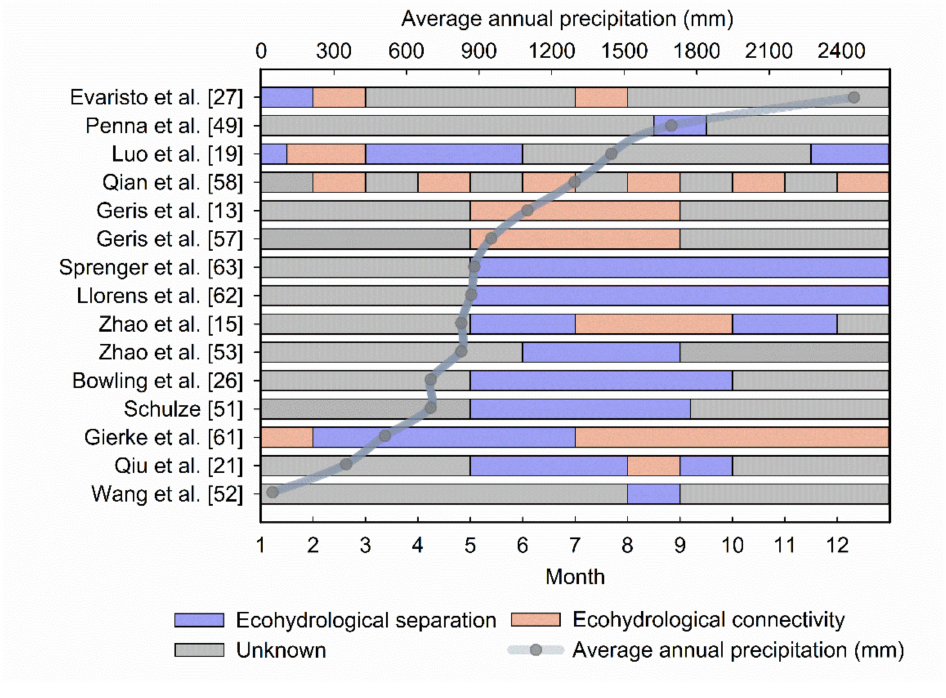
Figure 4. Relationship of ES occurrence period and the length of study period of each